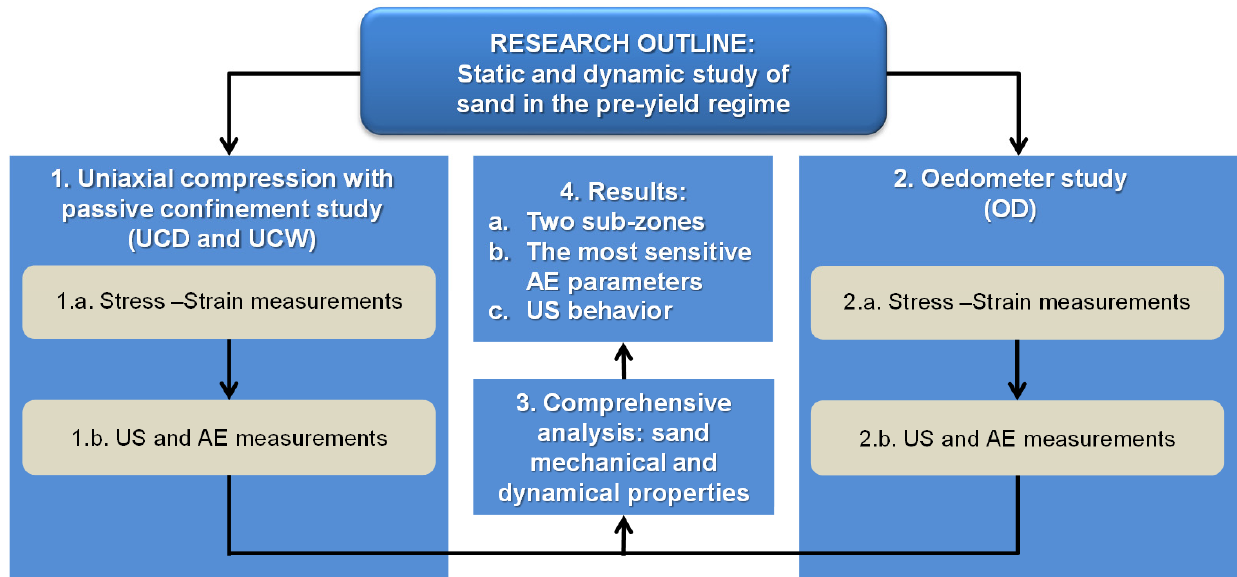
Figure 2. Block diagram presenting the research outline. The key objective of this research was the comprehensive experimental study of the mechanical and dynamical properties of sand in the pre-yield regime by means of combined acoustic emission (AE) and ultrasound (US) analysis.